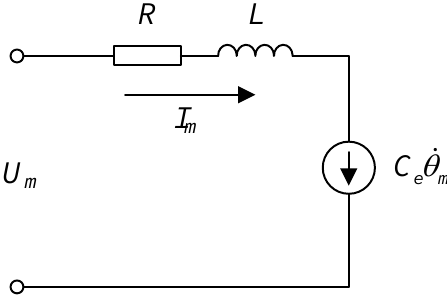
Figure 2. The structural schematic diagram of the gimbal servo system.